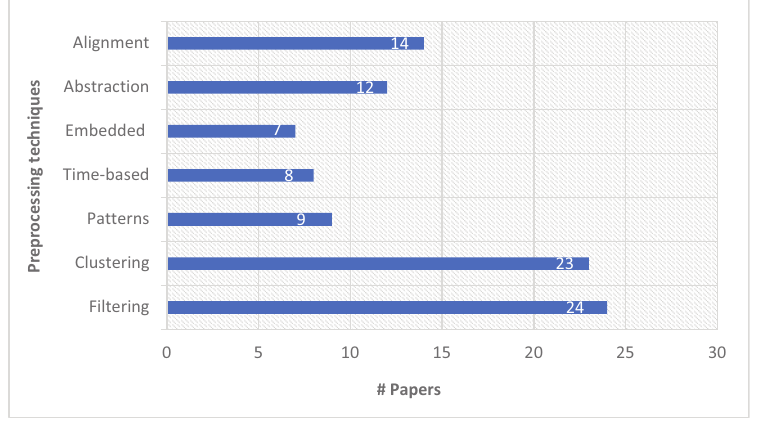
Figure 8. Preprocessing techniques and their distribution according to the proposed classification in this